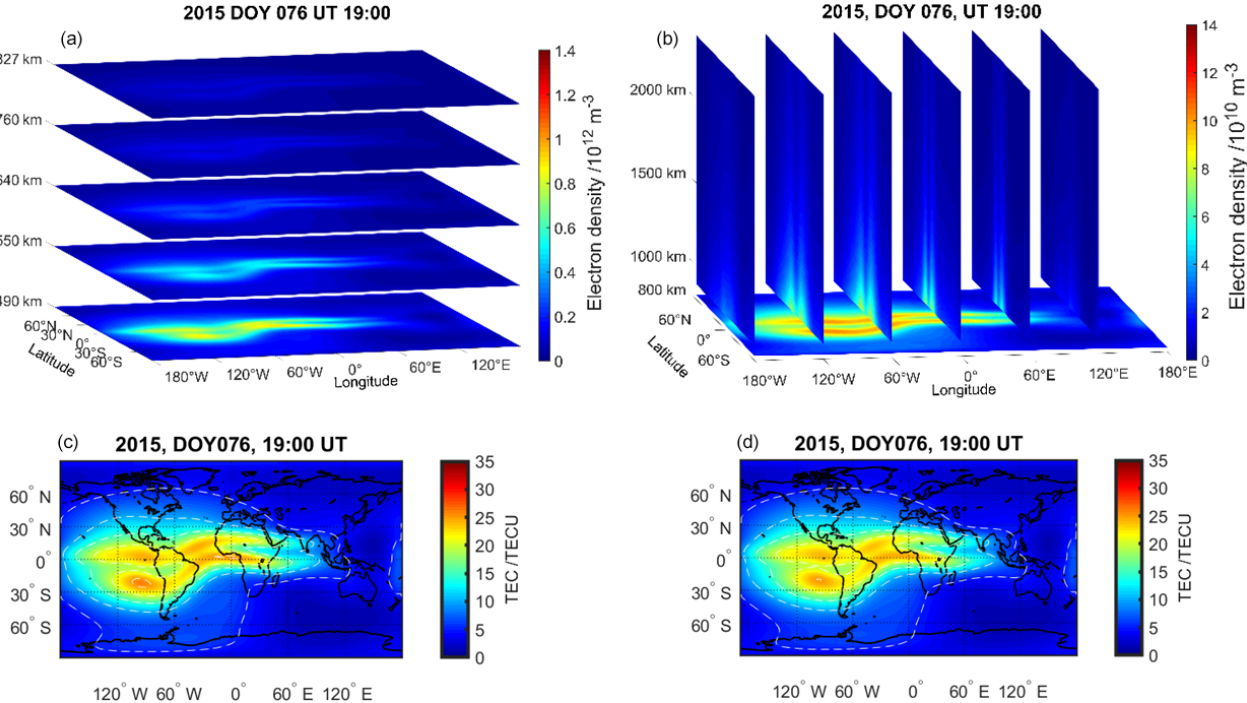
Figure 2. Rotation with exponential decay reconstructed electron density, represented by layers at different heights between 490 and 827km (a) and at chosen longitudes for altitudes between 827 and 2400km (b) . The vertical total electron content (TEC) map deduced from the reconstructed (c) and NeQuick-modelled (d) 3D electron density in the altitude range between 450 and 20200km.